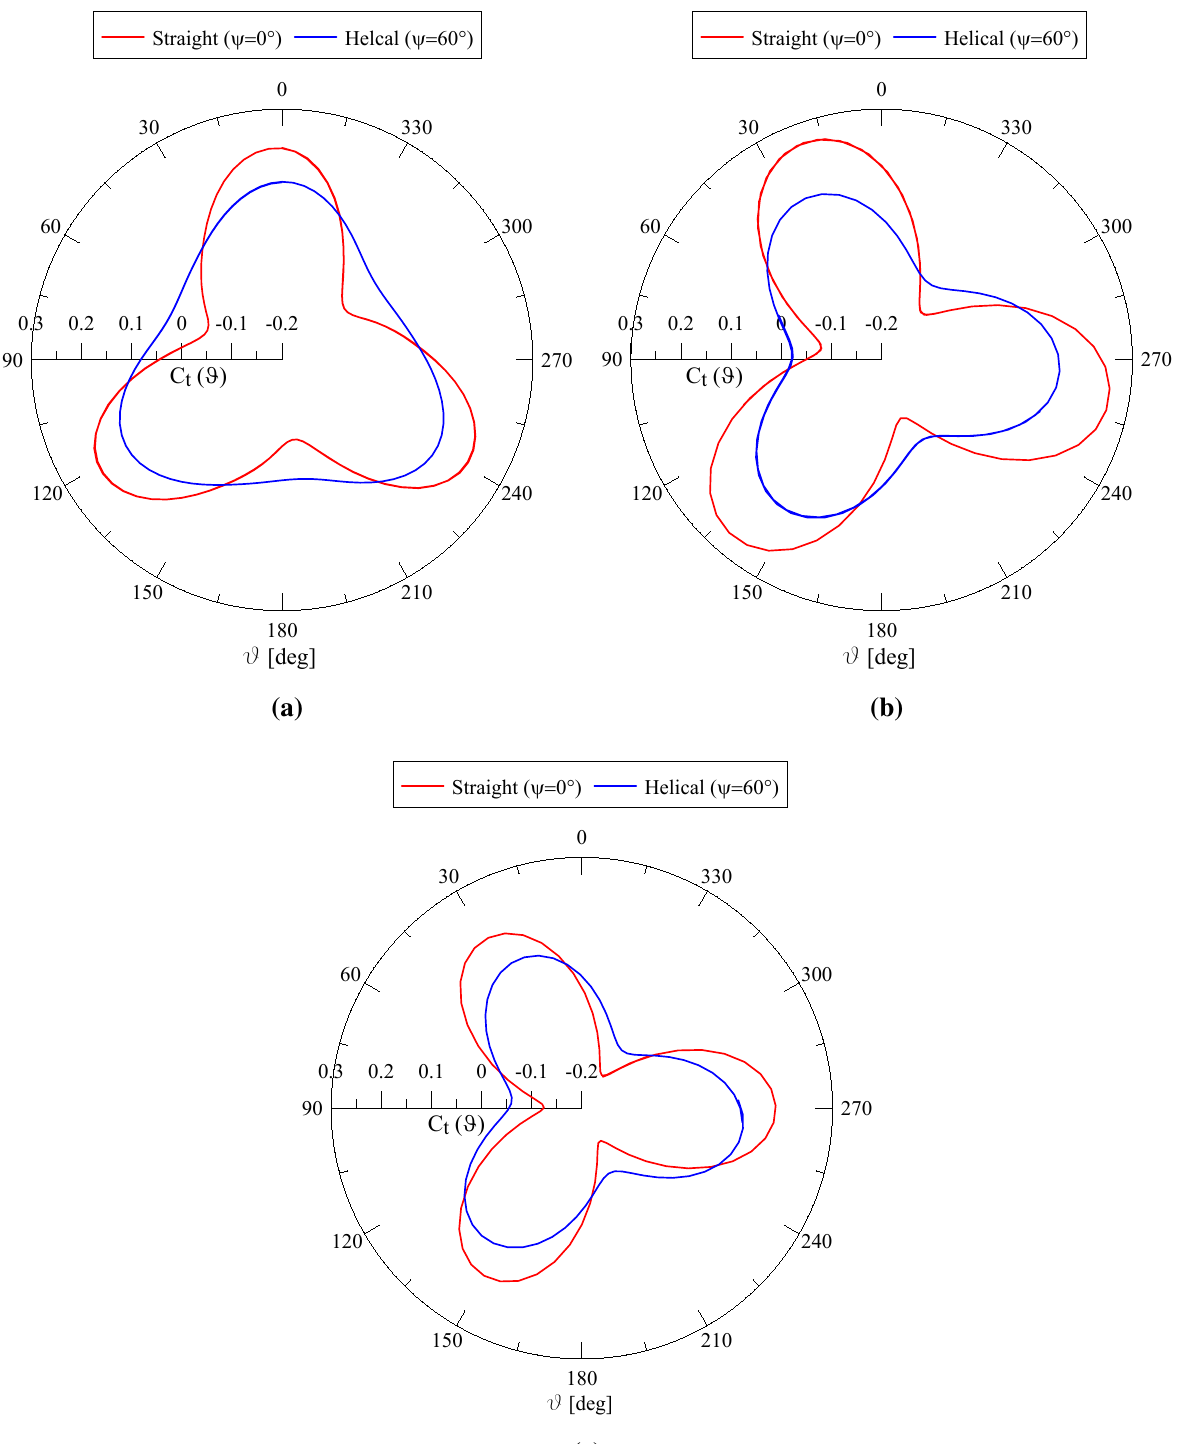
Figure 13. Instantaneous torque coefficient Straight blades with respect to Helical blades. ( θ ) , corresponding to a 60-RPM value; ( b ) rotor polar ( a ) Rotor polar behavior in terms of C t ( θ ) , corresponding to a 90-RPM value; ( c ) rotor polar behavior in behavior in terms of C t ( θ ) , corresponding to a 120-RPM terms of C t